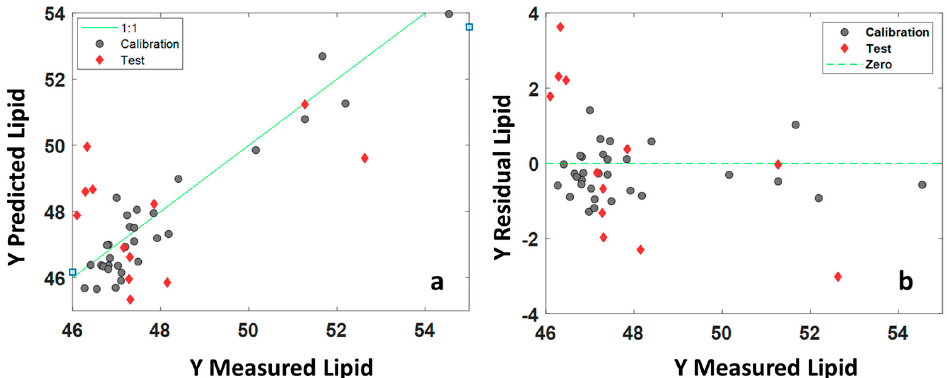
Figure 6. PLS results on NIR data for lipids content. Predicted vs. measured values plot ( a ), residuals vs. measured values plot ( b ).